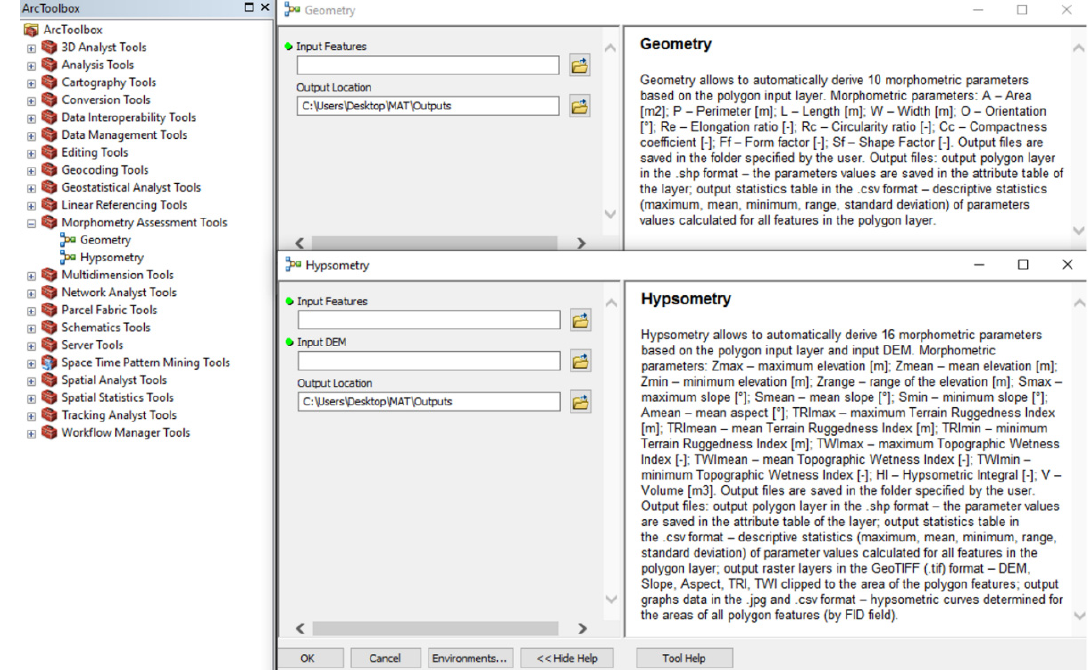
Figure 4. The interface of the MAT toolbox.